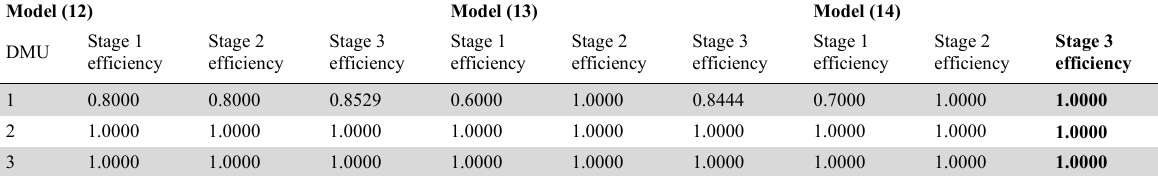
Numerical results for two-stage problems of model 1 with values of (cid:2012)(cid:2009) (cid:3404) (cid:2012)(cid:2010) (cid:3404) 0.1